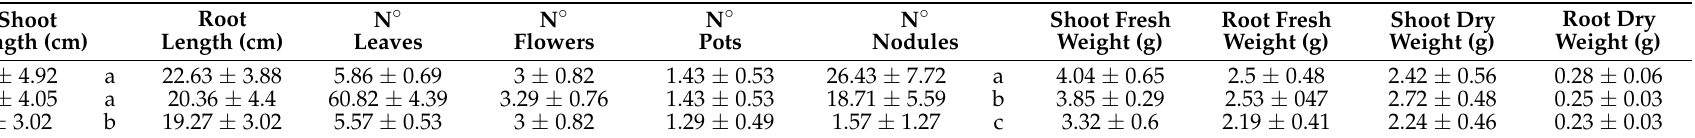
Table 5. Effect of rhizobia strain inoculation on the growth and root nodulation of red kidney beans under laboratory conditions.